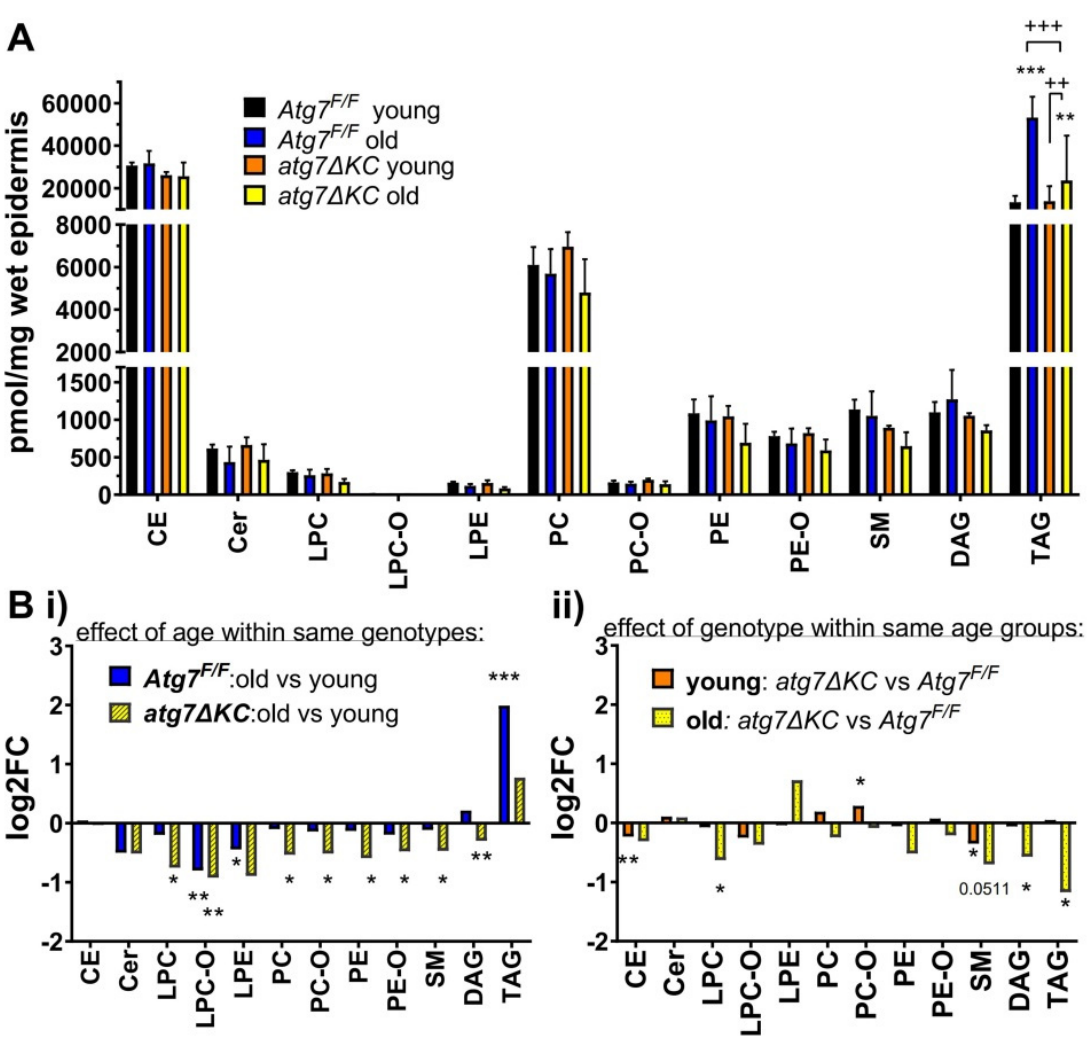
Figure 1. ( A ) Lipid classes identified in murine epidermal extracts. Absolute amounts are expressed as pmol/mg of hydrated epidermal tissue. Two-way ANOVA with Bonferroni’s multiple comparisons test, mean ± standard deviation. * marks a significant difference compared to the control group (Atg7 F/F young), + shows a significant difference between two respective groups indicated by a line segment; * p < 0.05, **/++ p < 0.01, ***/+++ p < 0.001; n = 4 (for Atg7f/f young and old, and atg7 Δ KC young) and 5 (for atg7 Δ KC old). ( B ) Regulation of lipid classes by age and genotype. Panels show fold change of individual lipid classes ( i ) in aged animals compared to their young counterparts and ( ii ) in animals of different genotypes but of comparable age. Student’s t ‐ test, log fold change (mean of replicate values of the given group divided with a mean of replicates of a reference group). * marks a significant difference compared to the reference group; * p < 0.05, ** p < 0.01; n = 4 (for Atg7f/f young and old, and atg7 Δ KC young) and 5 (for atg7 Δ KC old). CE: cholesteryl ester, Cer: ceramide, LPC: lysophosphatidylcholine, LPC ‐ O: ether ‐ linked LPC, LPE: lysophosphatidylethanolamine, PC: